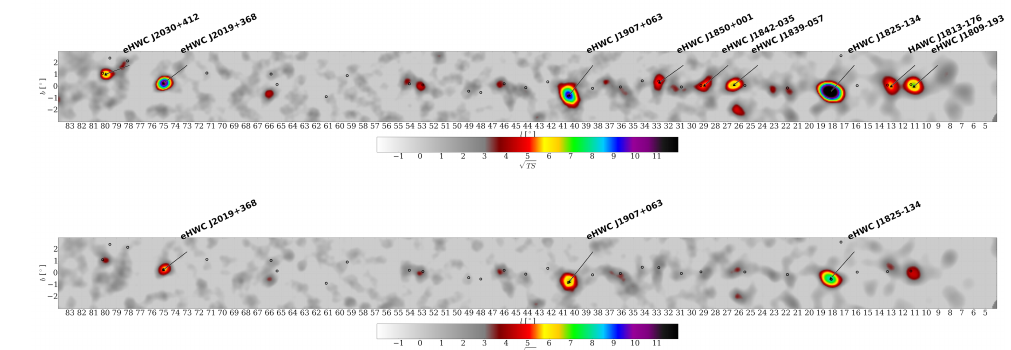
Figure 7. TS map of the Galactic plane for photon energies above 56 TeV (top panel) and above 100 TeV (bottom panel). A disk of radius 0.5 degree is assumed as the morphology. Black triangles denote the high energy sources. For comparison, black open circles show sources from the second HAWC catalog [61–64,72].